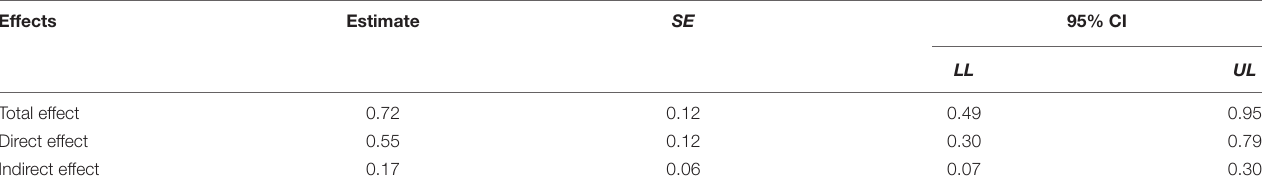
TABLE 4 | Mediation analysis: mediating effect of positive emotions between imagery ability and exercise intentions.